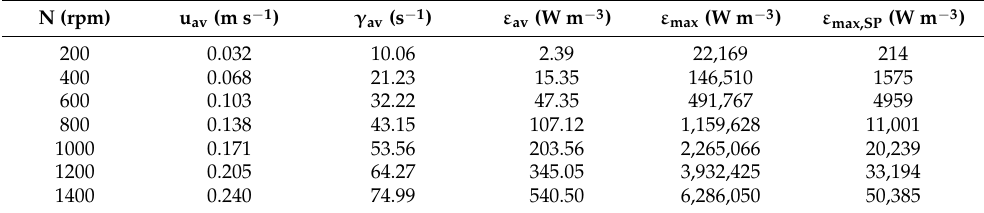
Table A1. Hydrodynamic parameters in the SIS based on CFD simulations. All values above 800 rpm were extrapolated linear (velocity and shear rate) or quadratic, respectively (energy dissipation rate).